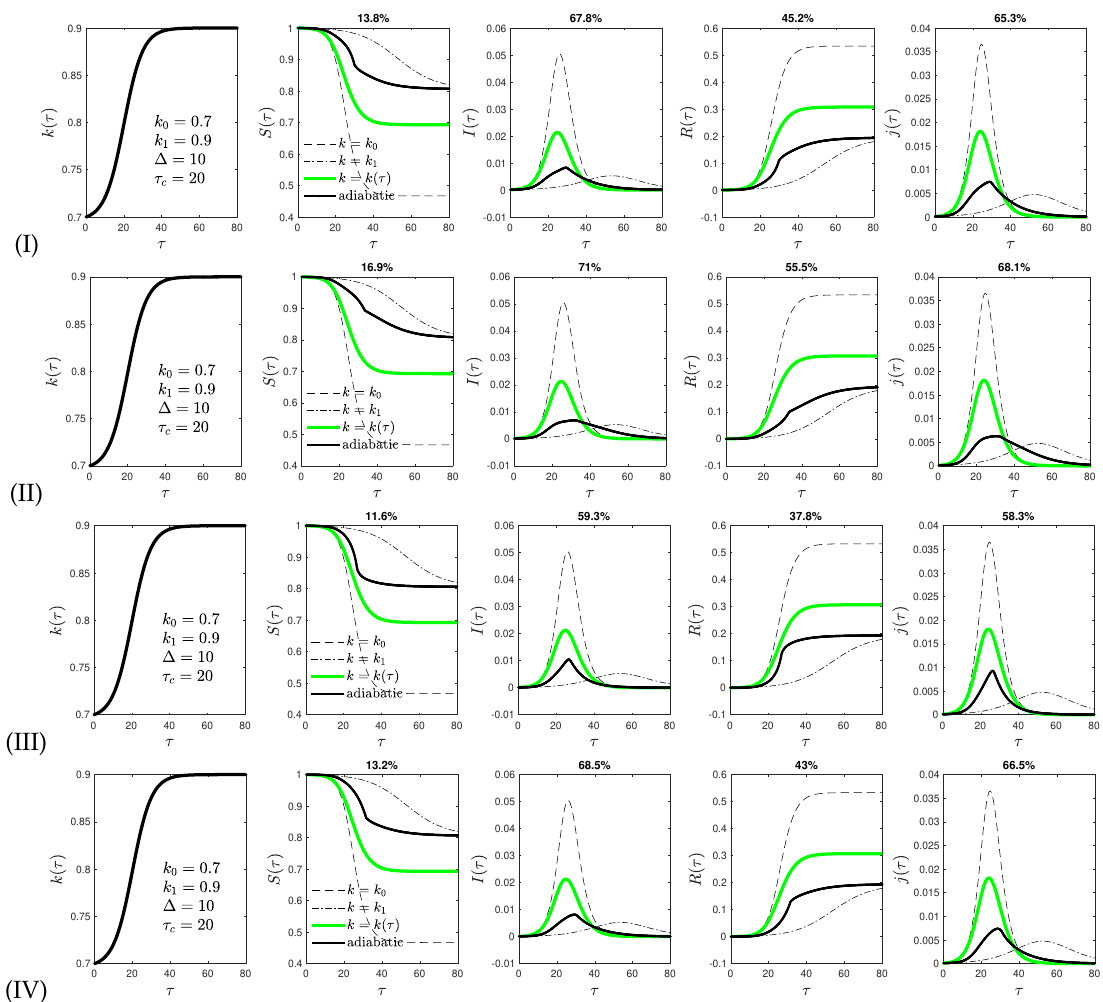
Figure 8. Same as Figure 2 but with another set of the parameters ( k 0 = 0.7, k 1 = 0.9, ∆ = 10, and τ c = 20) of the ratio k ( τ )